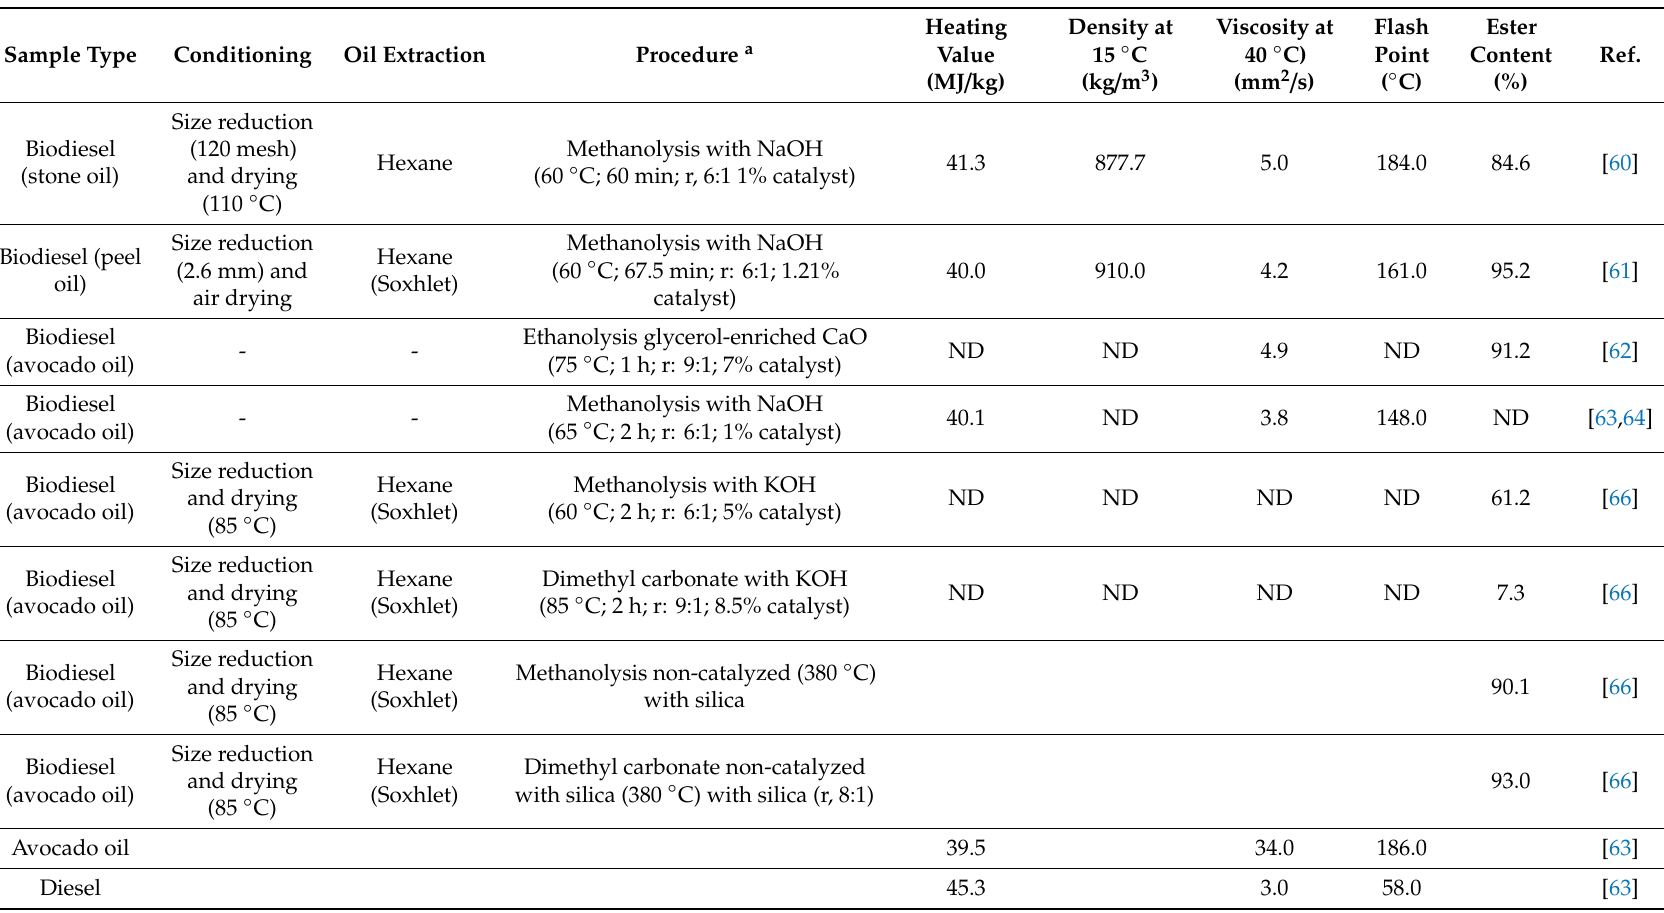
Table 4. Methods applied to obtain biodiesel from avocado stone and peel oils and avocado oil, as well as the characteristics of the